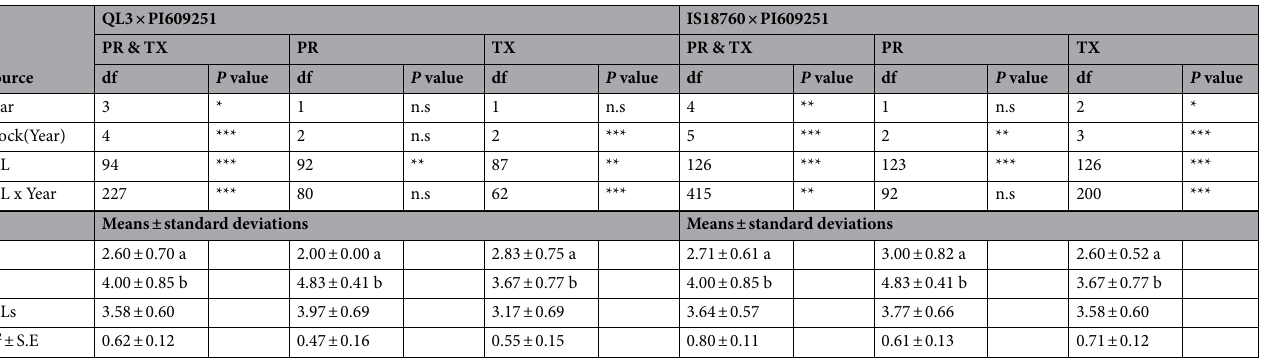
Table 1. Analysis of variance for the anthracnose resistance response (1–5 scale) of two recombinant inbred line (RIL) populations derived from the crosses between QL3 and IS18760 with a common susceptible line PI609251 evaluated at Puerto Rico (PR) and Texas (TX) in 2016, 2017 and 2018. n.s., *, ** and *** refers to no significance and significant differences at P < 0.05, 0.01 and 0.001, respectively. H 2 and S.E refers to broad-sense heritability estimates and standard error, respectively. P 1 refers to the resistant parent of the RILs population and P 2 to PI609251.